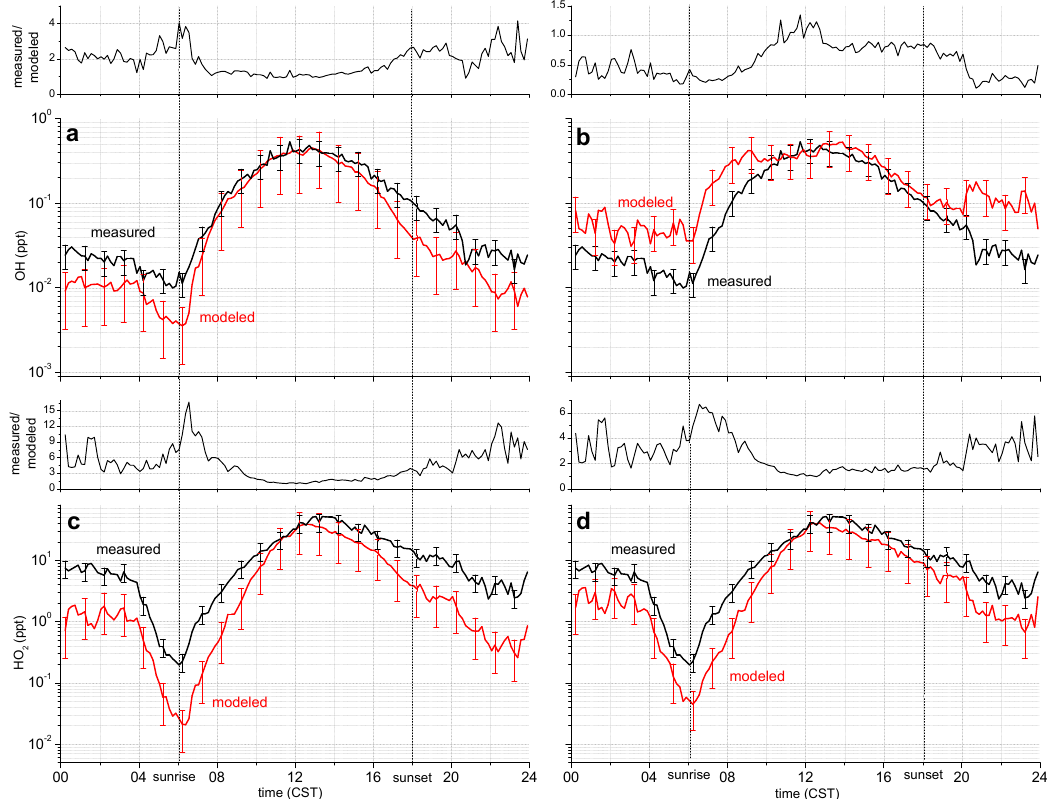
Fig. 3. Measured (black) and modeled (red) diurnal concentrations of HO x are shown for each of the three balanced model cases: (a) OH, HO x -unconstrained, (b) OH, HO 2 -constrained, (c) HO 2 , HO x -unconstrained, and (d) HO 2 , OH-constrained. In the upper panel of each graph, the measured-to-modeled ratios are also shown. Note that for the top panels of OH, A and B, “measured” refers to values reported by Shirley et al. (2006) multiplied by 1.3 and include a 0.01ppt offset subtracted from the measured values as discussed in the text and in Volkamer et al.